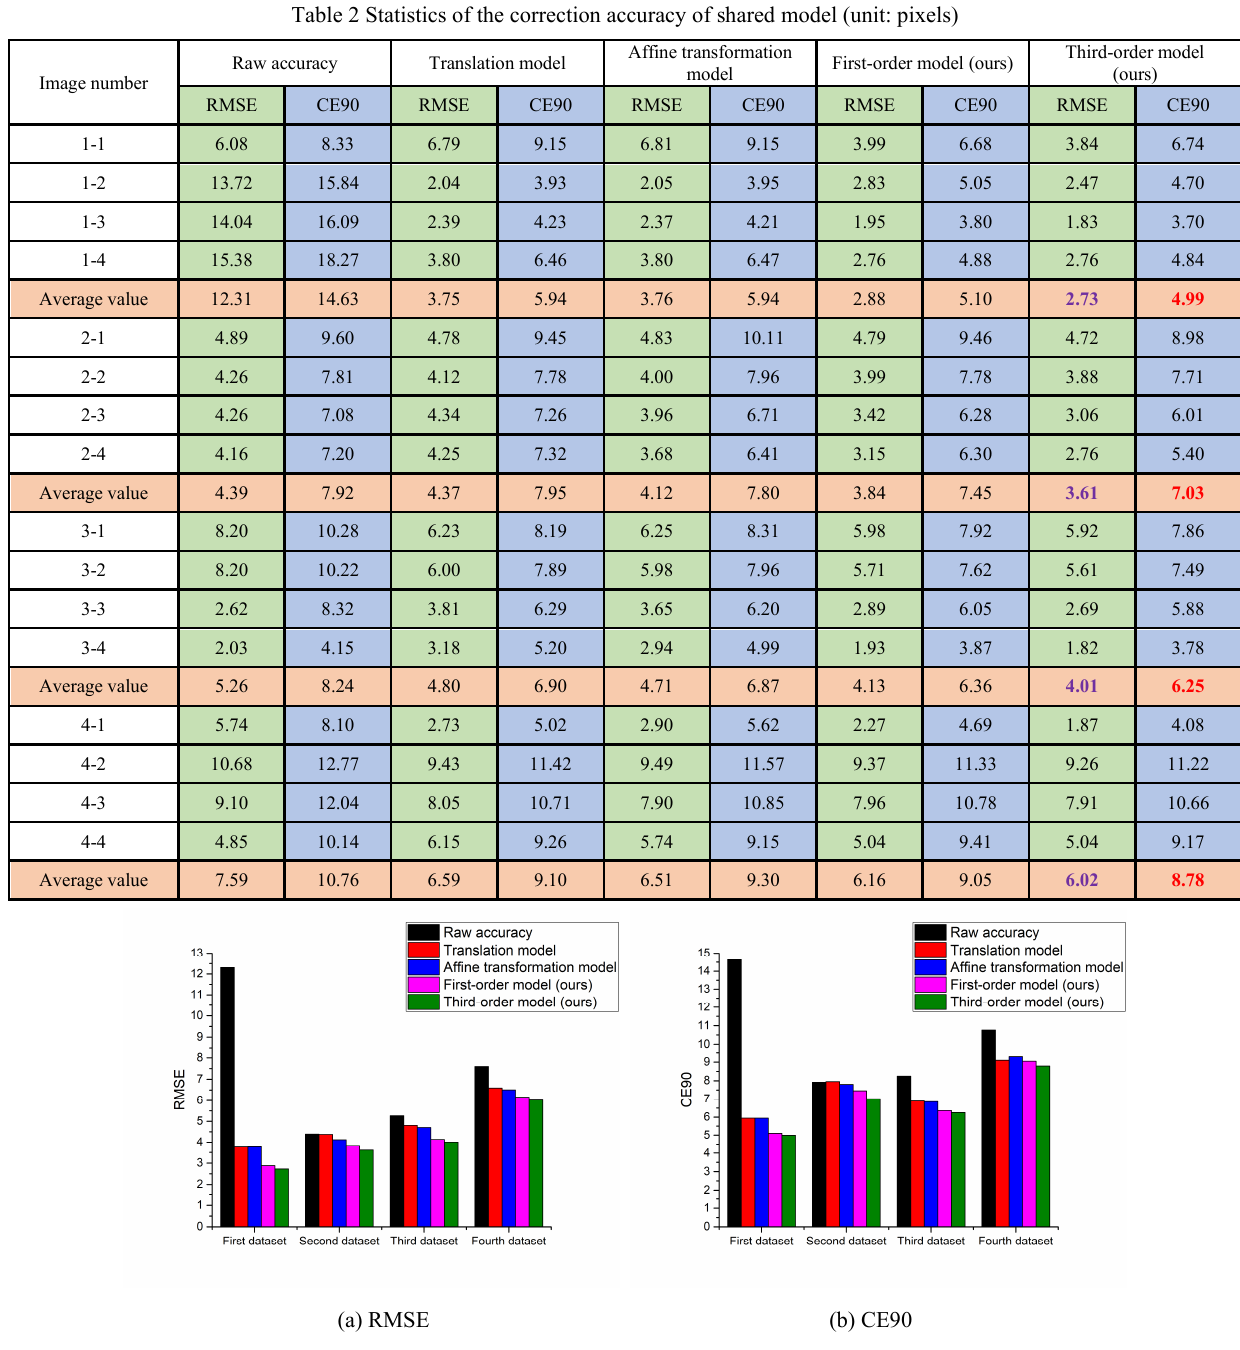
Figure 3 Adjustment accuracy